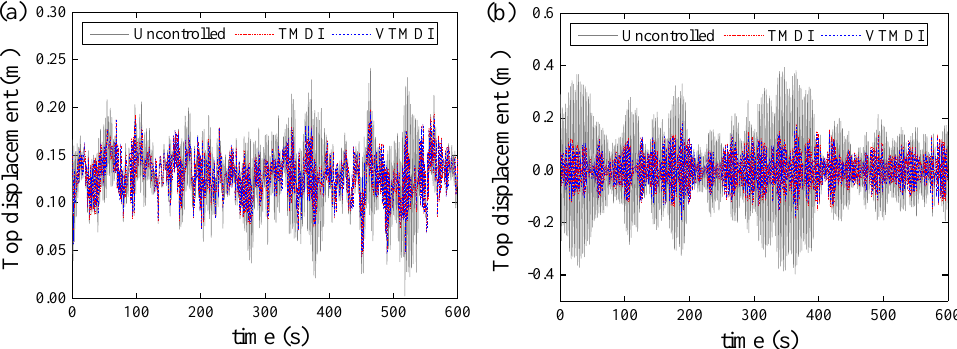
Figure 6. The time-history of wind-induced top displacement responses of uncontrolled and con-